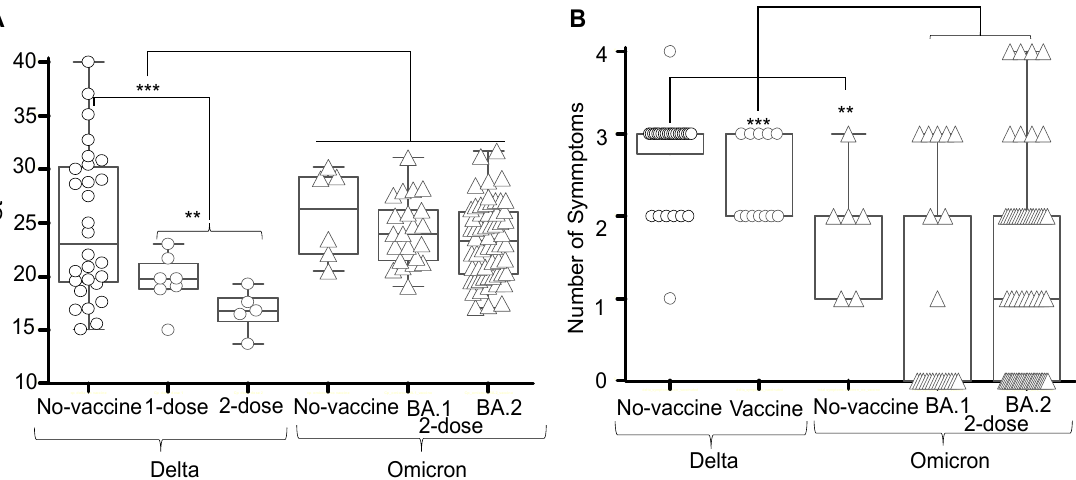
Figure 1. Viral loads and symptoms in the COVID-19 Delta variant versus the COVID-19 Omicron variants. Viral loads ( A ) and Symptoms ( B ). ** p < 0.02 and *** p < 0.0001. Delta variant Ct median 19.9 (95% CI 19.3–22.8 and micron variants Ct median 23.85 (95% CI 22.8–24.8).